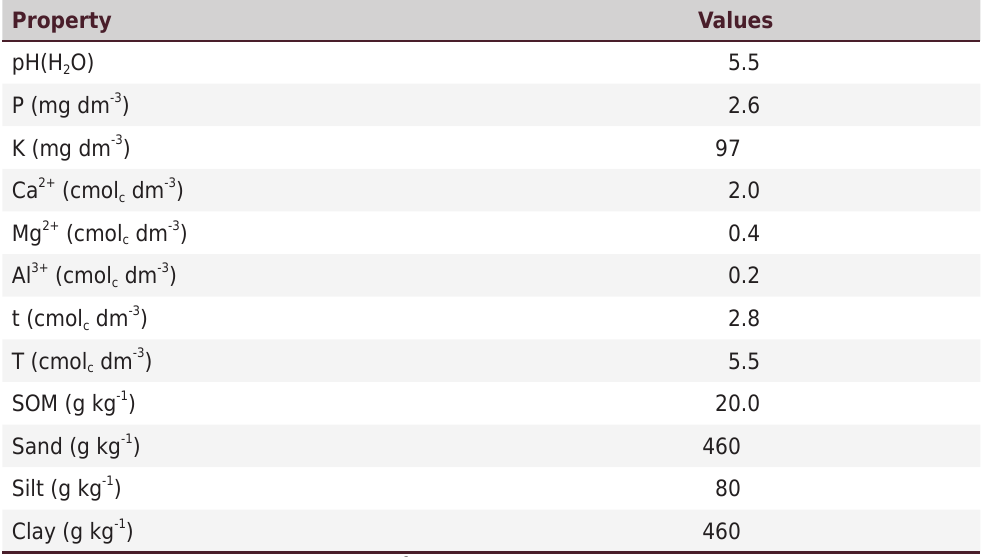
Table 1. General characterization of the soil from experimental area at a 0.00-0.20 m depth